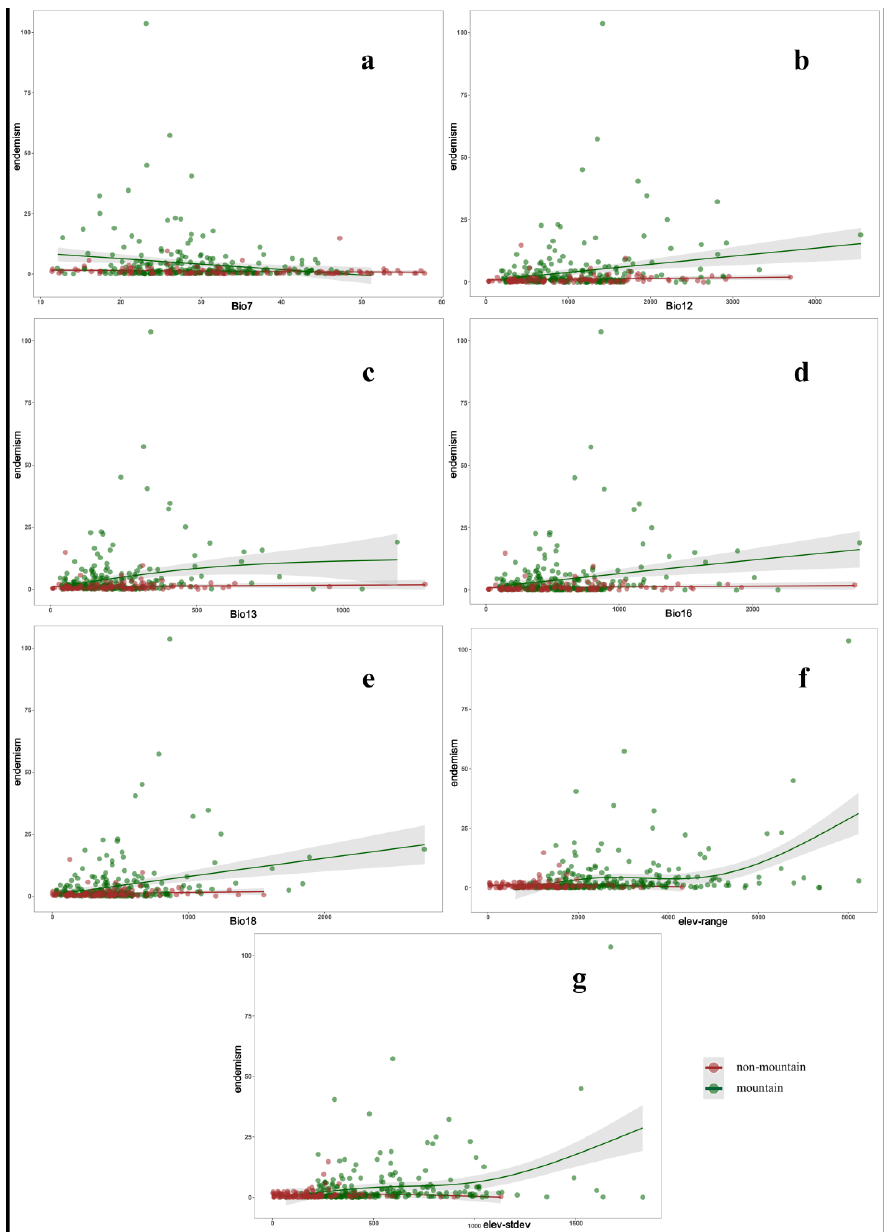
Figure 5. Relationships between endemism and environmental factors based on the generalized additive model in the Qinghai-Tibet Plateau and its surrounding area. ( a ) Bio7: Temperature Annual Range; ( b ) Bio12: Annual Precipitation; ( c ) Bio13: Precipitation of Wettest Month; ( d ). Bio16: Precipitation of Wettest Quarter; ( e ) Bio18: Precipitation of Warmest; ( f ) elev-range: elevation range; and ( g ) elev-stdev: elevation standard deviation. Gray borders around the lines indicate confidence intervals.